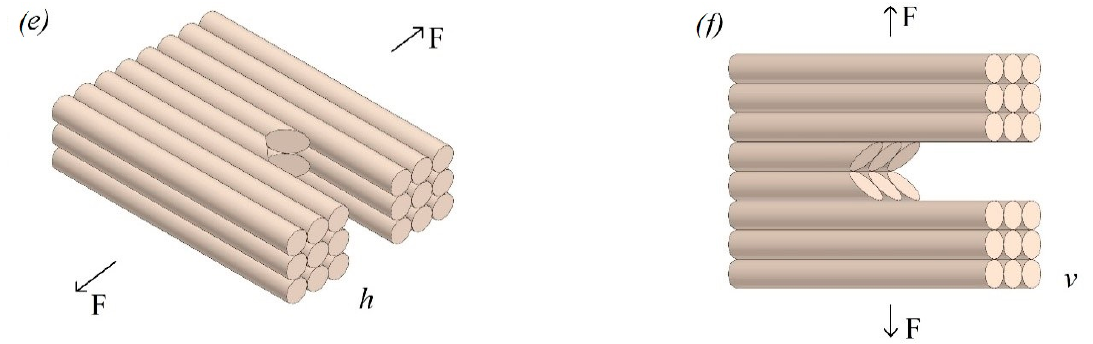
Figure 1. ( a ) Geometry of FFF manufactured PEEK samples for tensile and CT tests. Printing scheme for tensile samples for three configurations of infill angle: ( b ) 𝛼 = 45 °, ( c ) 𝛼 = 90° and ( d ) 𝛼 = 180°. Configuration of the CT samples: ( e ) horizontal orientation h , ( f ) vertical orientation v.